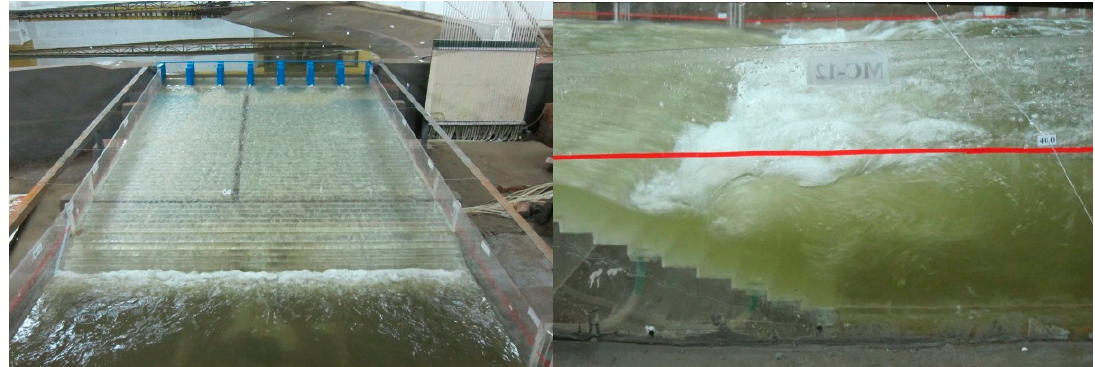
Figure 14. Steady flow and hydraulic jump when Z up = 55.86 m in the design case [16].